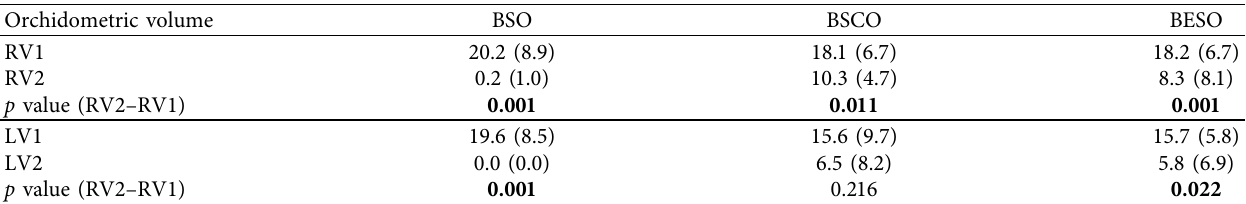
Table 5: Comparison between the testicular and pseudotesticular volumes from the different orchidectomies (significant differences in volume are emboldened).